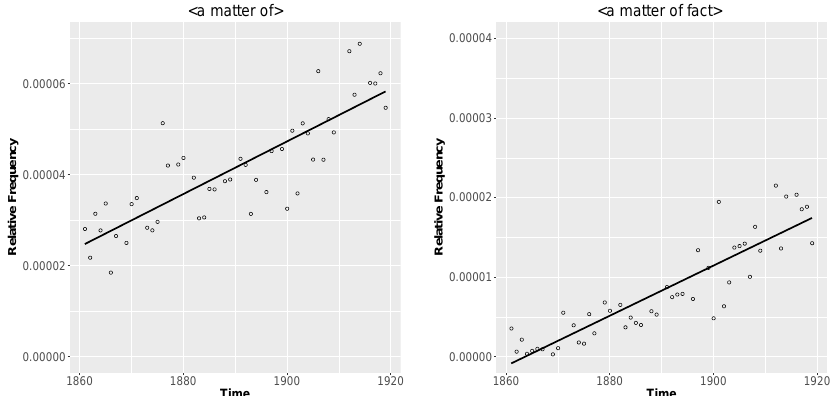
Figure 4: Reference corpus: relative frequency for h a matter of i and h a matter of fact